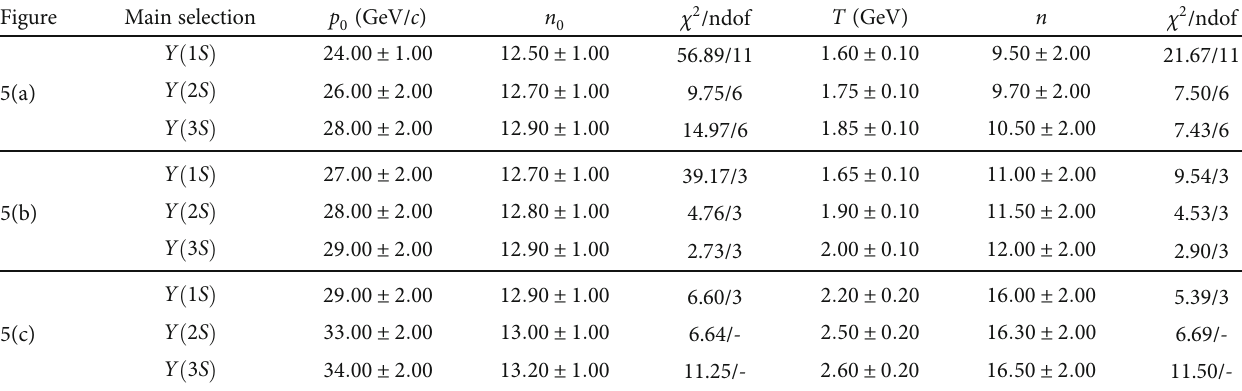
(c) Values of p 0 , n 0 , and χ 2 /ndof corresponding to the dashed curves in Figures 5 and 6, as well as values of T , n , and χ 2 /ndof corresponding to the dotted curves in Figures 5 and 6 Figure Main